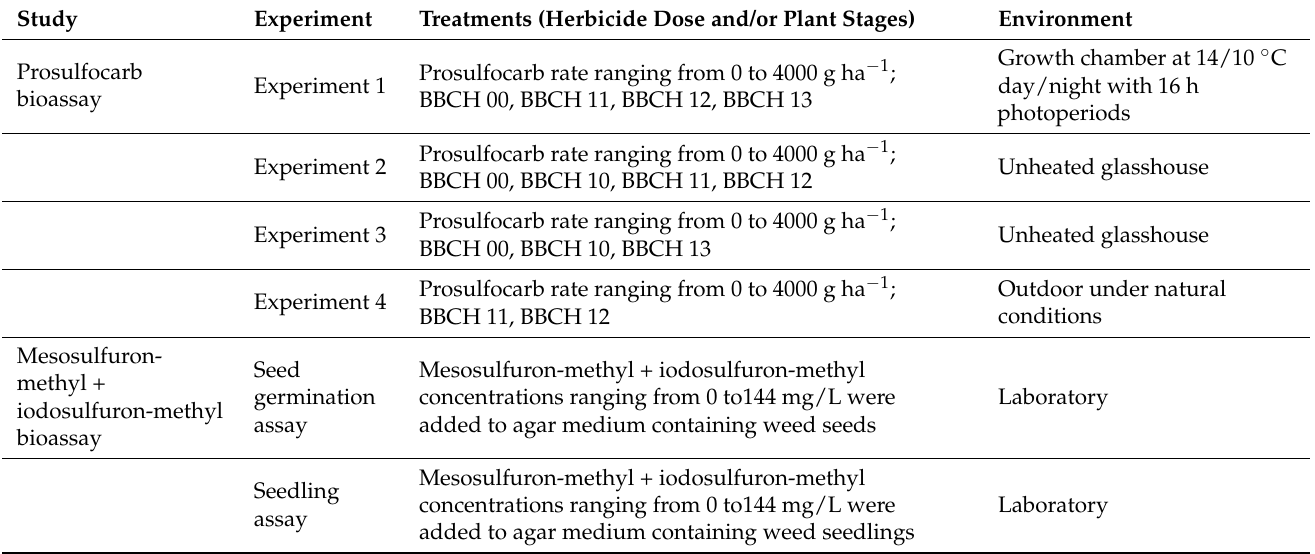
Table 1. A table displaying the set-up of different experiments carried out to examine the level of the lower performance of prosulfocarb and mesosulfuron-methyl + iodosulfuron-methyl in V. myuros .